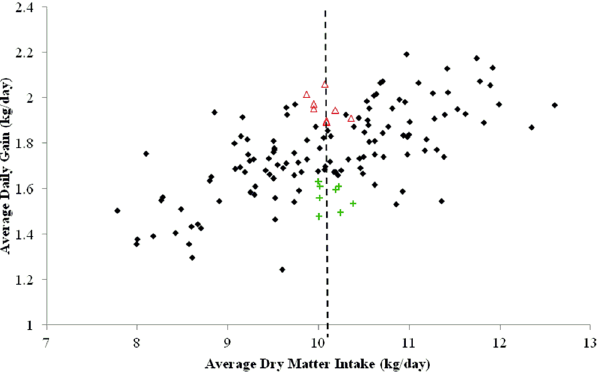
Figure 6. Rumen sampling selection. The two animals groups were selected by the greatest average daily gain (high-ADG; open red triangle; n = 8) and the least ADG steers (low-ADG; green plus; n = 8) with similar average dry matter intake (dash line) from the total population (black dots; n = 144)